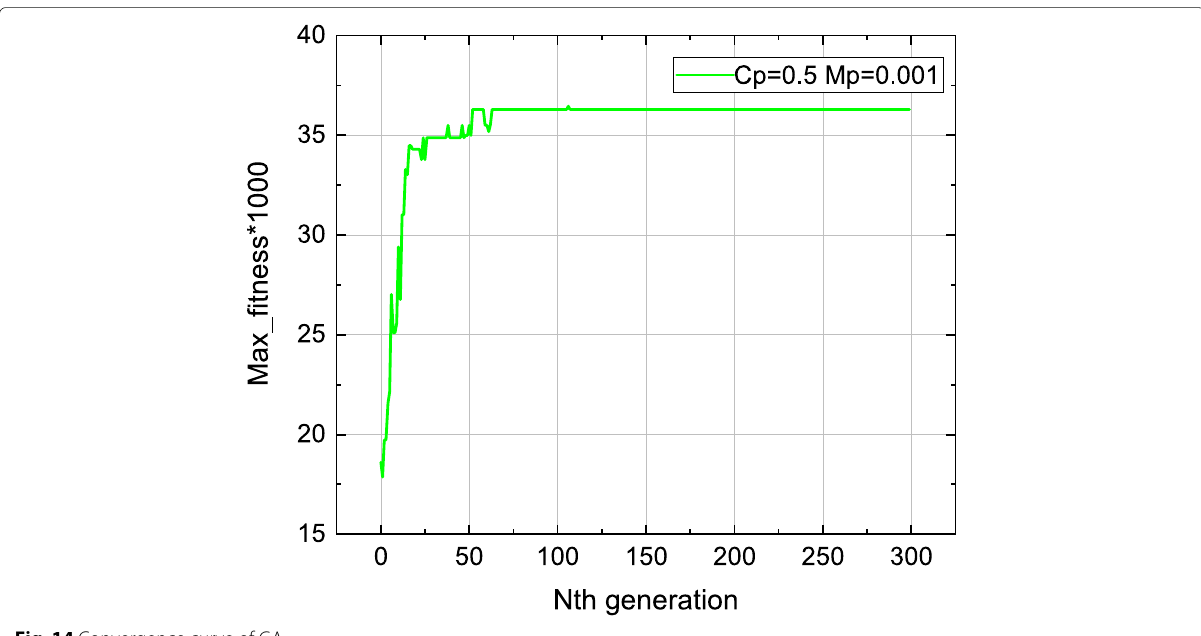
Fig. 14 Convergence curve of